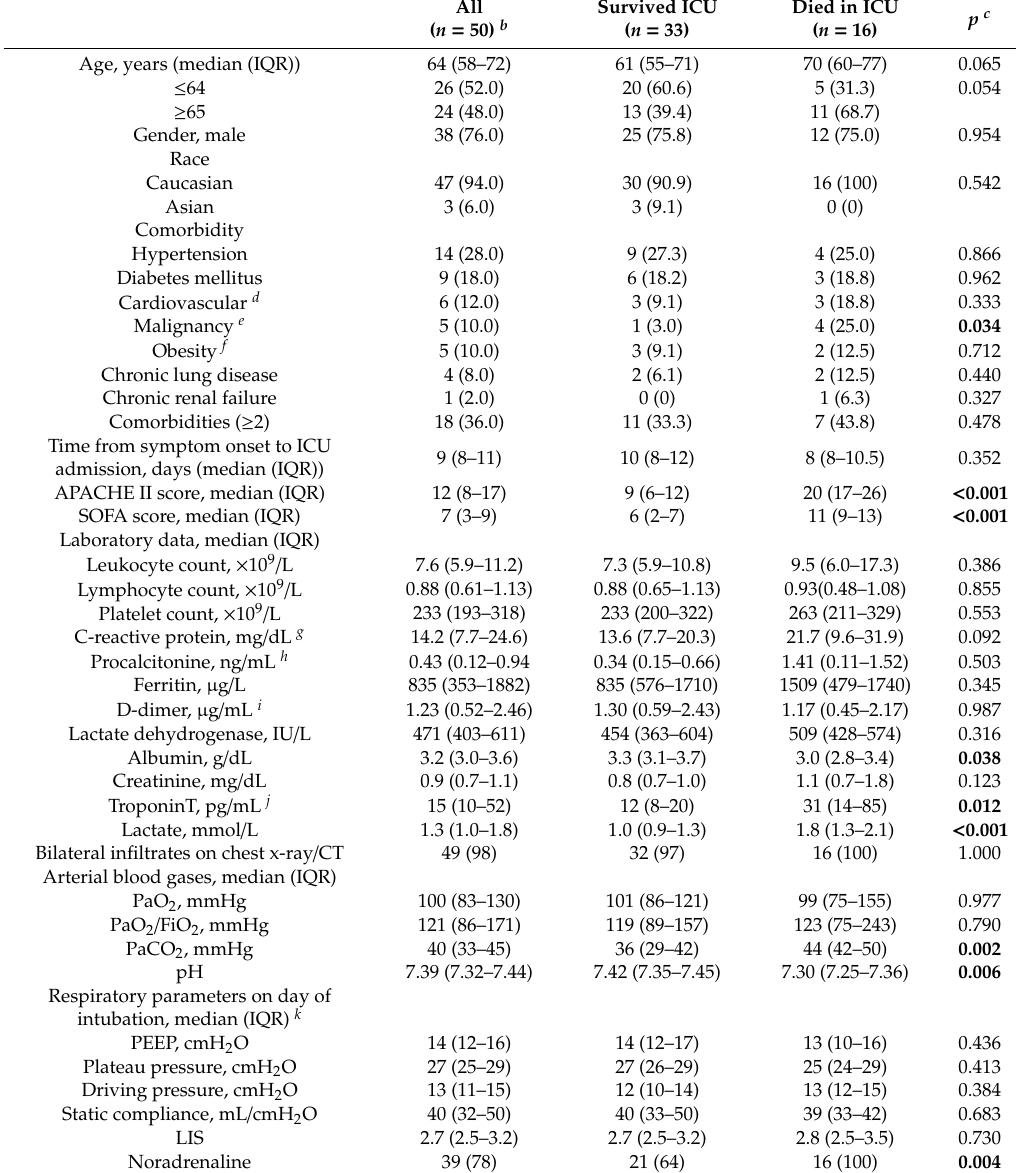
Table 1. Demographics and clinical and laboratory data on ICU admission of patients with COVID-19 a